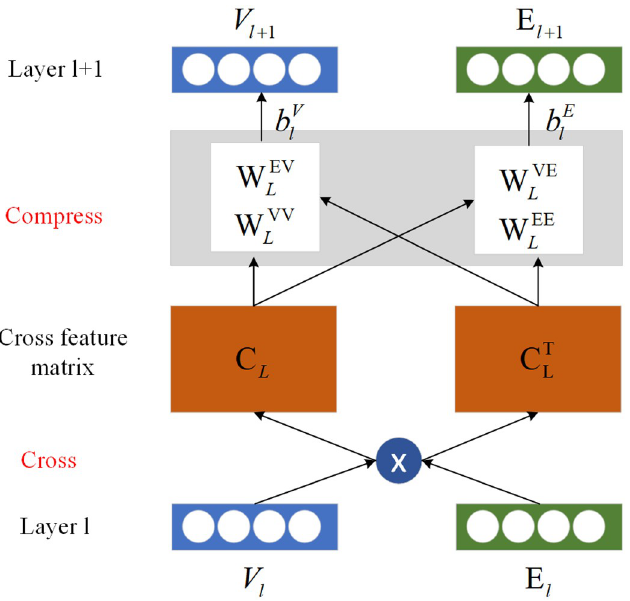
Fig 4. The illustration of cross&compress unit. The item and entity vectors are operated by cross function to generate the cross feature matrix.